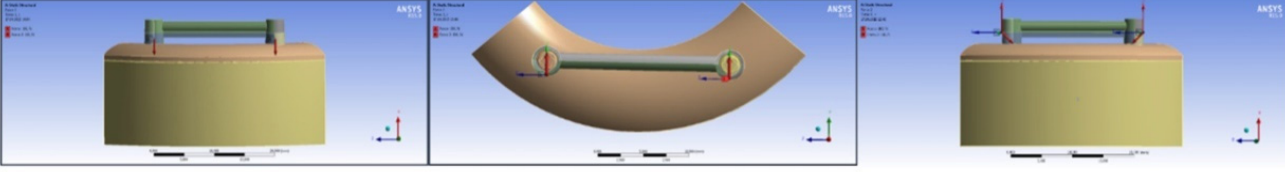
Figure 2. Loads of 100 N in vertical direction, bucco-lingual direction and oblique direction, respec- tively.